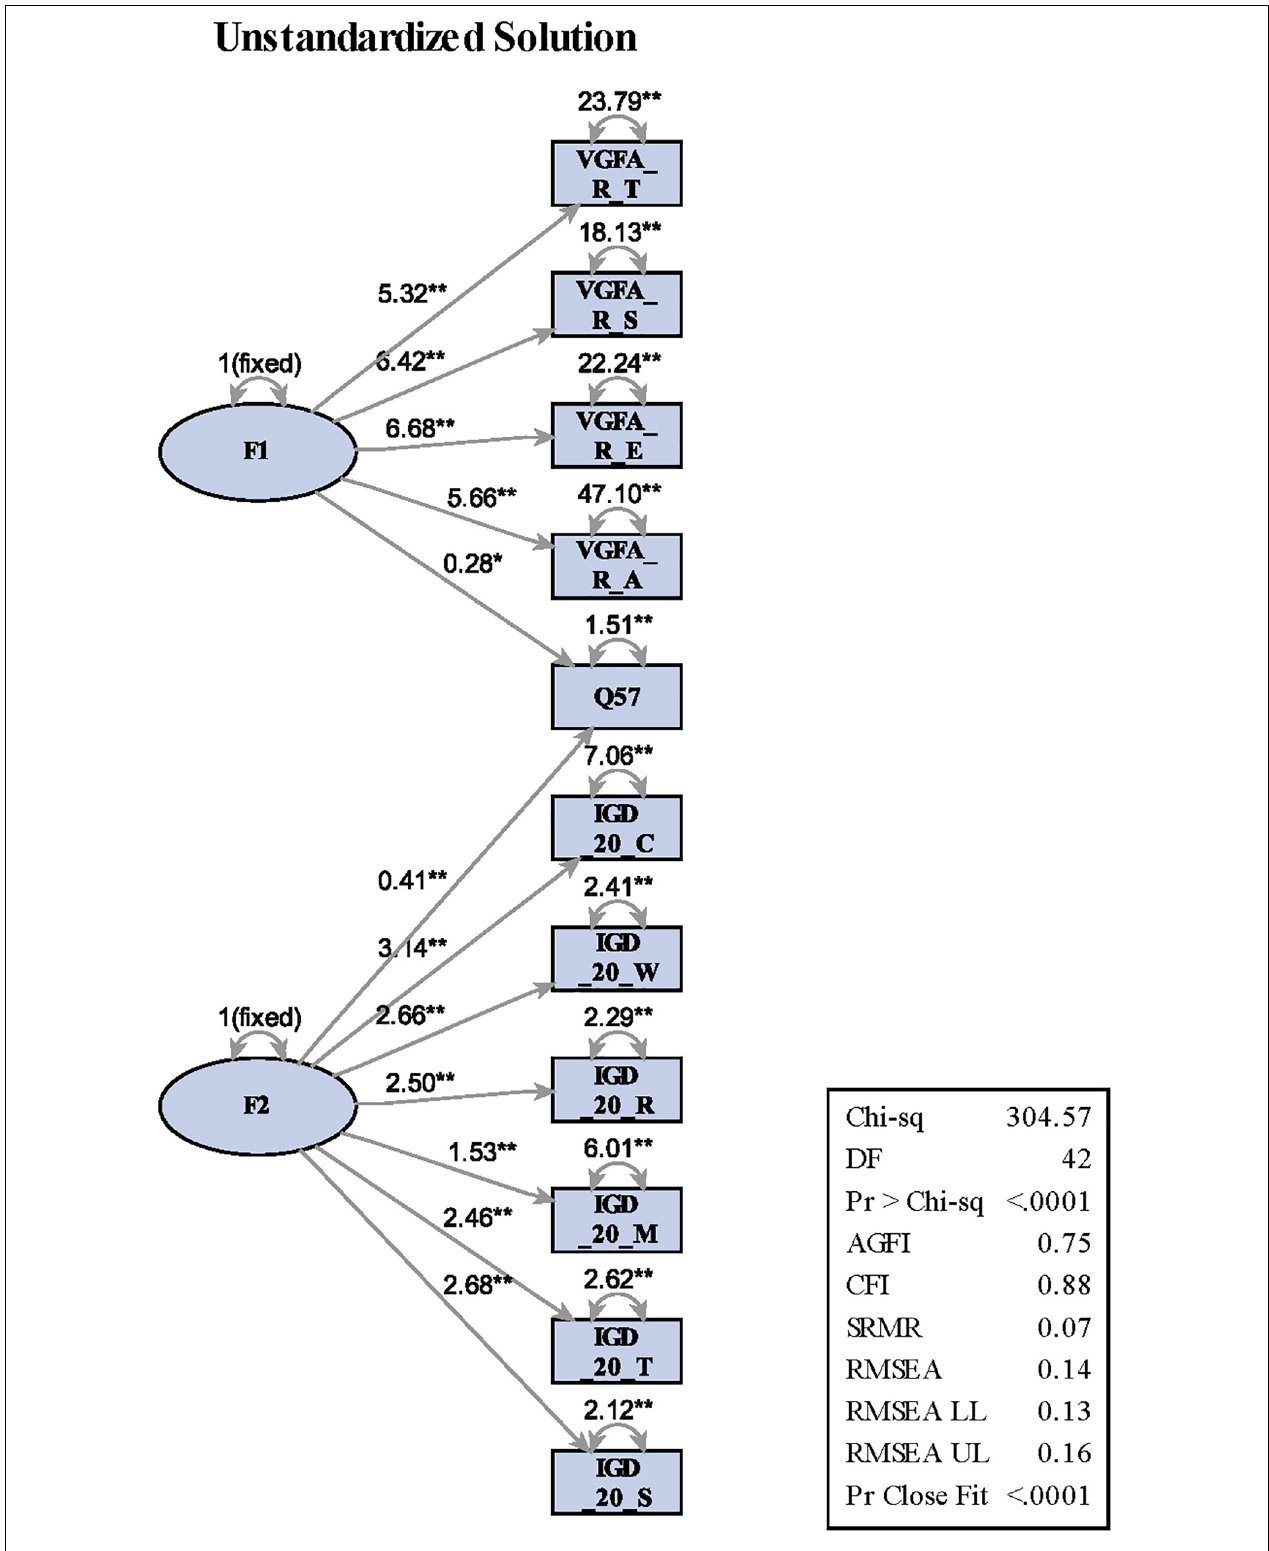
FIGURE 1 | The unstandardized solution for the VGFA-R and IGD-20.